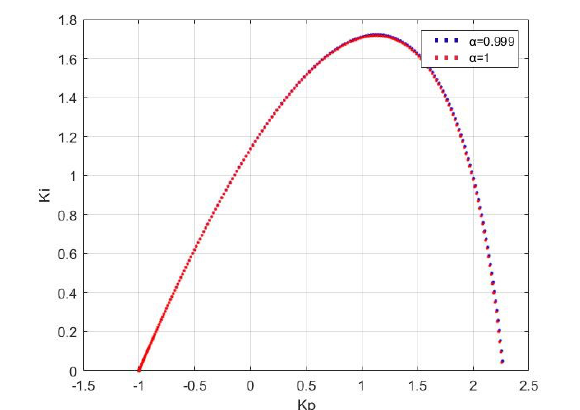
Figure 2. Stability regions for α = 0 . 999 and α = 1 using second order approximation.